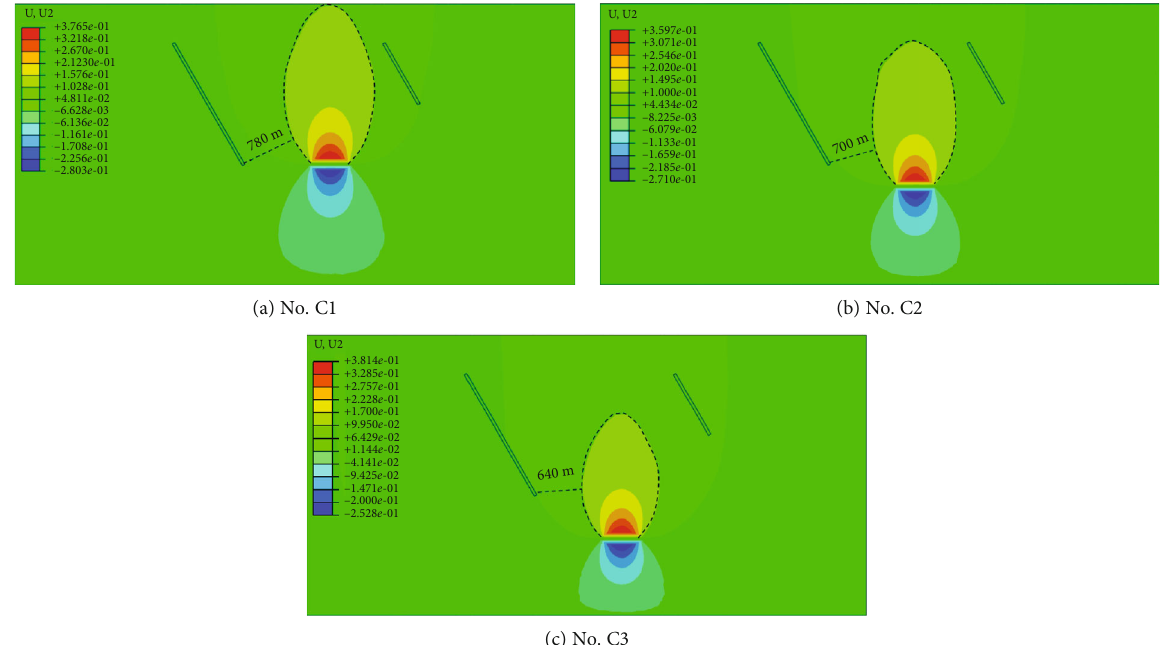
Figure 21: Distribution vertical displacement when fracturing region is N1 (a), N2 (b), and N3 (c).